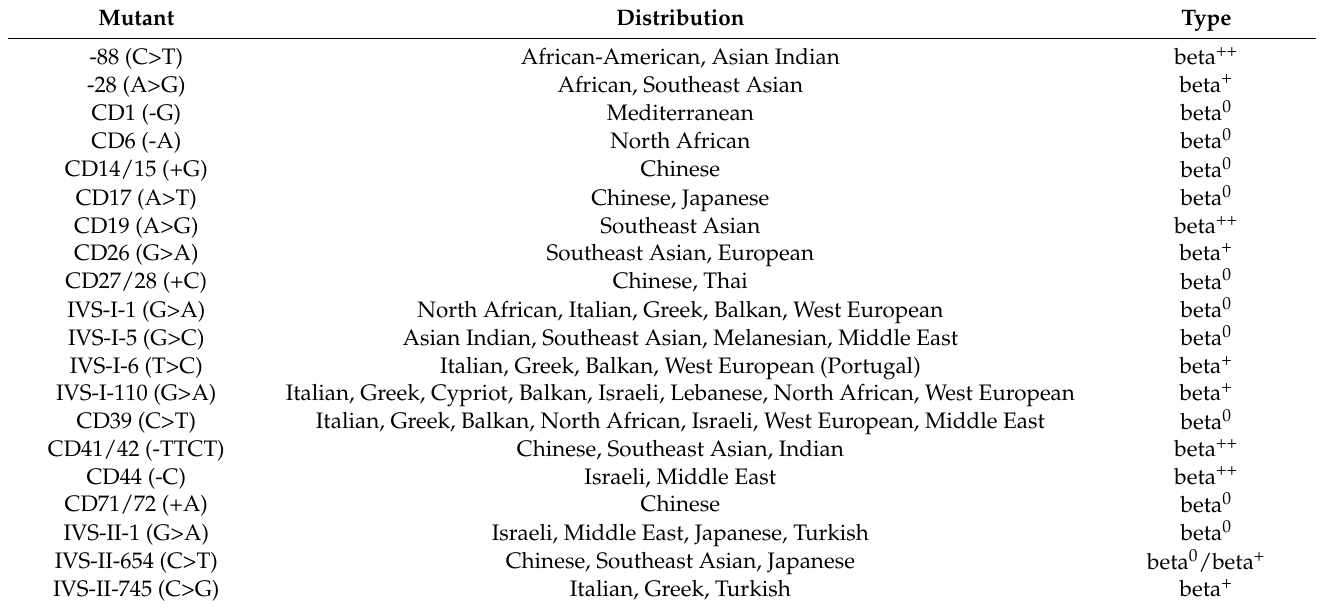
Table 1. Twenty most prevalent beta-thal alleles [9]. beta ++ , beta + , and beta 0 refer to silent, moderate, and severe degrees of beta-thal,